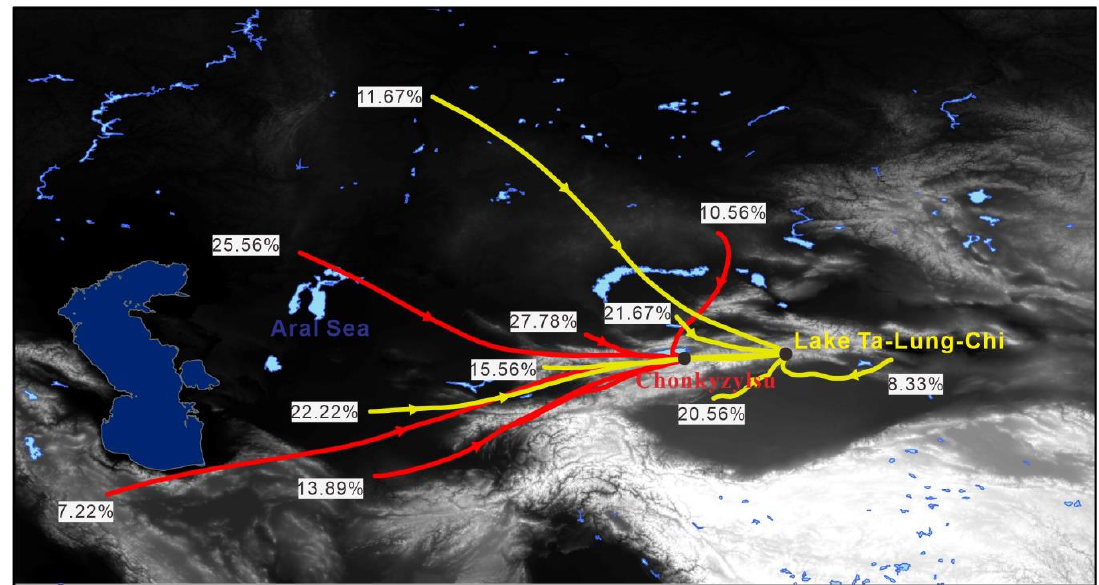
Figure 7. Possible sources of water vapor identified for Lake Ta-Lung-Chi (42.45 ◦ N, 83.29 ◦ E) and Chonkyzylsu station (42.20 ◦ N, 78.19 ◦ E) using the HYSPLIT [40] and MeteoInfo (TrajStat package) [42] models. The base map was derived from SRTM 90 m Digital Elevation Database v4.1 [87]. The red lines suggested the cluster trajectories of water vapor source for the site of Chonkyzylsu Station, and the yellow for Lake Ta-Lung-Chi.